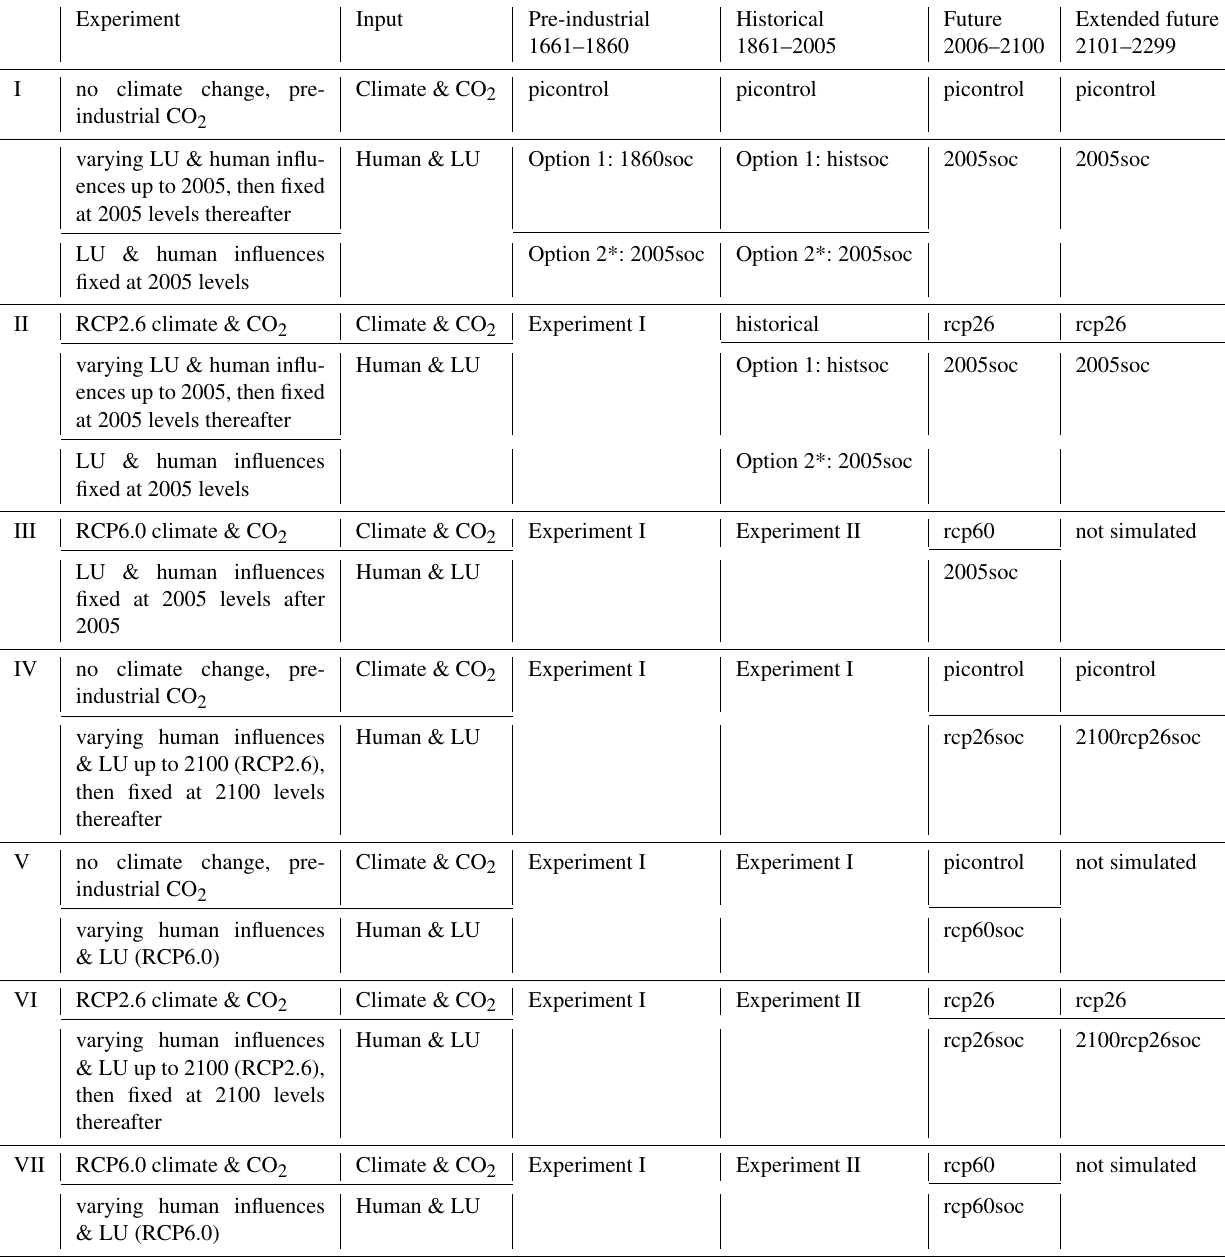
Table 7. ISIMIP2b scenario specification example for the global and regional water model simulations. Option 2* only if option 1 not